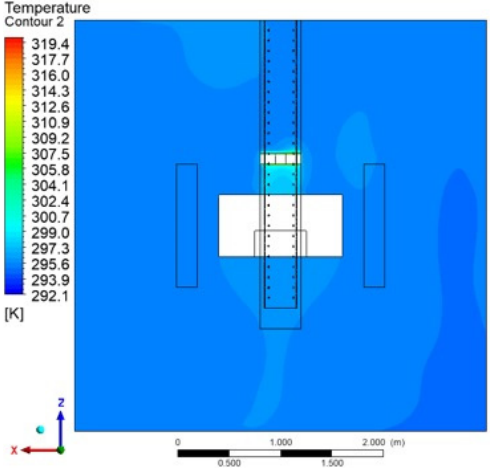
Figure 13. The temperature distribution of the Y = 0.6 m section.